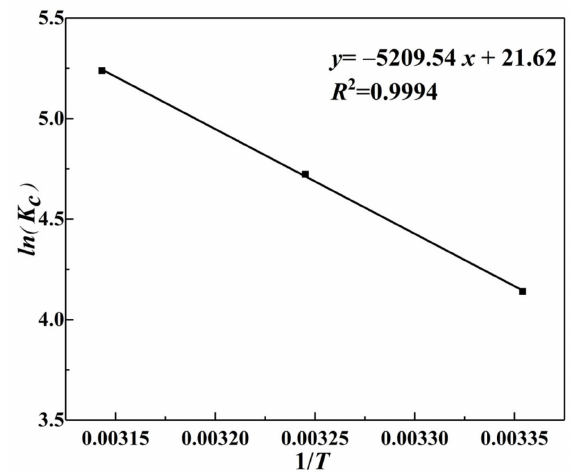
Figure 13. Van’t Hoff curve of α –FeO(OH)/GOCS adsorption of